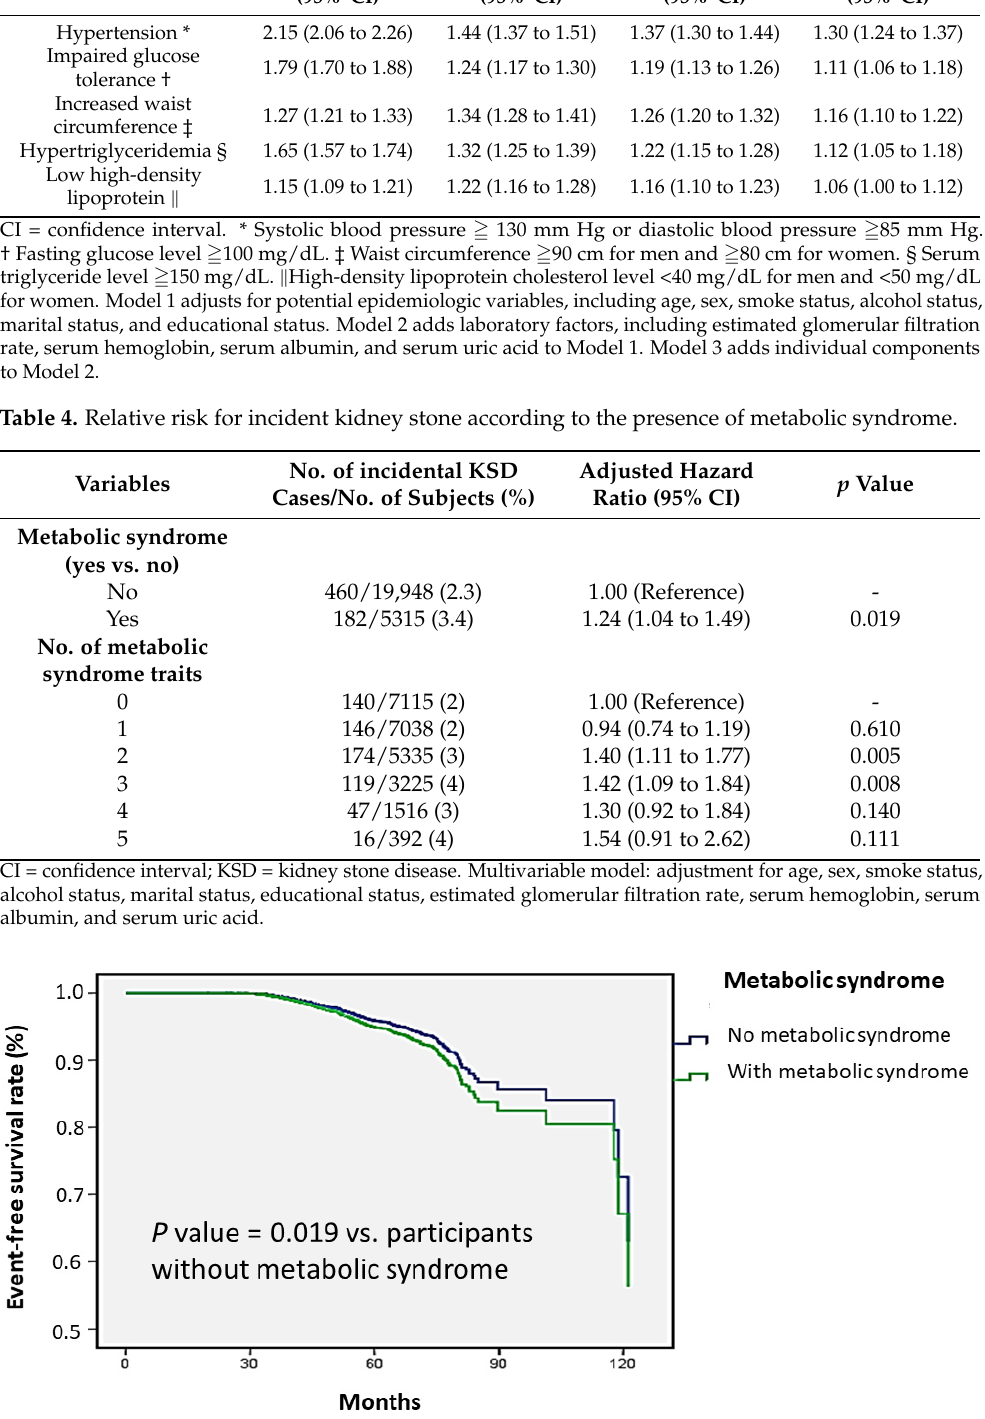
Figure 1 . Time to kidney stone disease development was longer in participants without metabolic syndrome than participants with metabolic syndrome. Kaplan–Meier plot of incident kidney stone disease development according to the presence of metabolic syndrome in 25,263 participants with follow-up